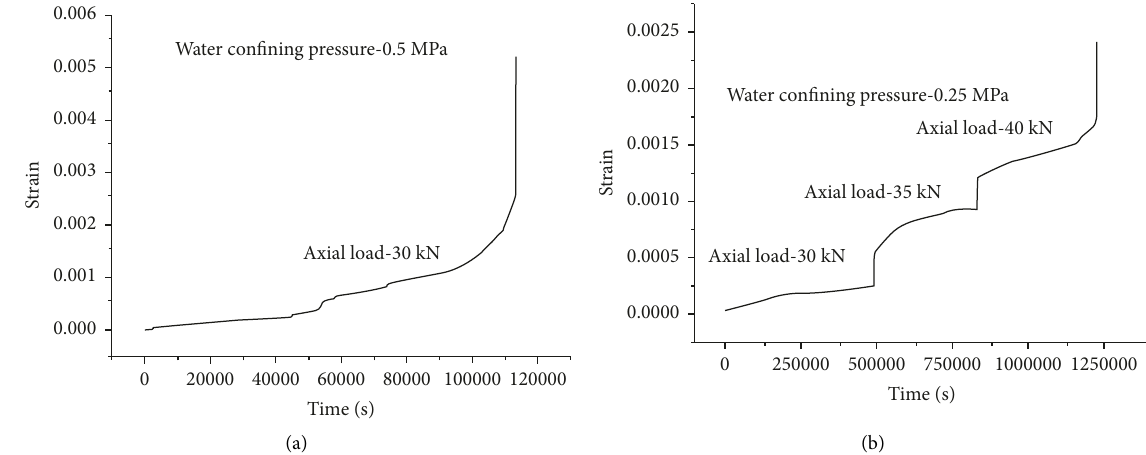
Figure 10: Creep mechanical properties of granite under different water confining pressures. (a) Rheological curve of rock when water confining pressure is 0.5MPa. (b) Rheological curve of rock when water confining pressure is 0.25MPa.